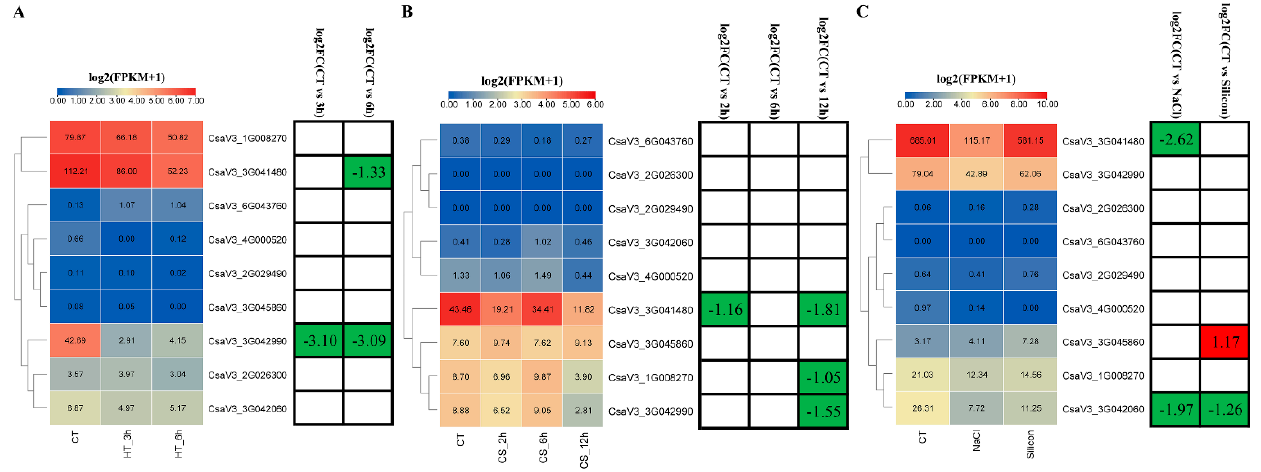
Figure 7. Expression heatmaps of cucumber GASA family genes under abiotic stresses. ( A ) Expression patterns of cucumber GASA family genes under high temperature stress. ( B ) Expression patterns of cucumber GASA family genes under low temperature stress. ( C ) Expression patterns of cucumber GASA family genes under salt and silicon stresses. CT: control treatment; HT_3 h: high temperature treatment for 3 h; HT_6 h: high temperature treatment for 6 h; CS_2 h: low temperature treatment for 2 h; CS_6 h: low temperature treatment for 6 h; CS_12 h: low temperature treatment for 12 h; NaCl: salt stress treatment. Silicon: silicon stress treatment. In each figure, the data in the left boxes indicate the original FPKM values. The data in the right boxes are log2(fold-change) values highlighted by red (up-regulation) and green (down-regulation) colors.